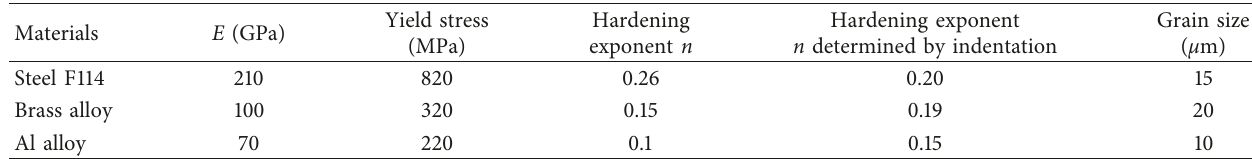
Figure 1: Equations (6) and (8) are in the same ln a- ln F coordinate, and “ e ” is the intersectional point. Table 1: Mechanical properties of steel F114, brass, and Al